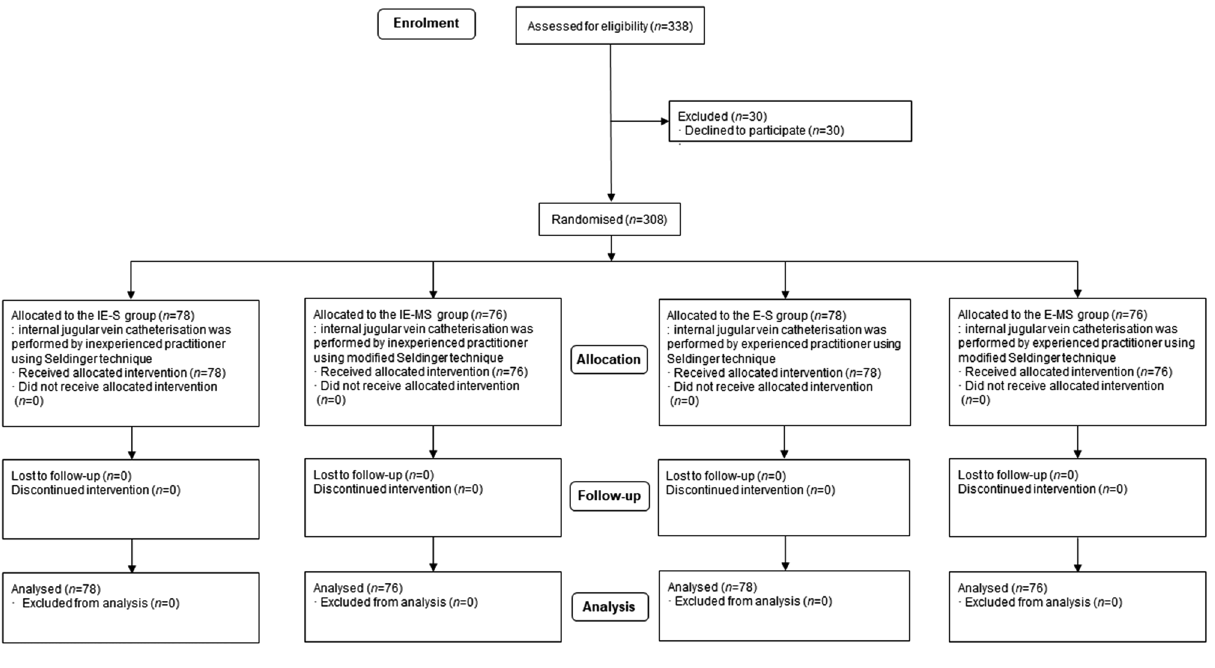
Figure 1. CONSORT flow diagram of the